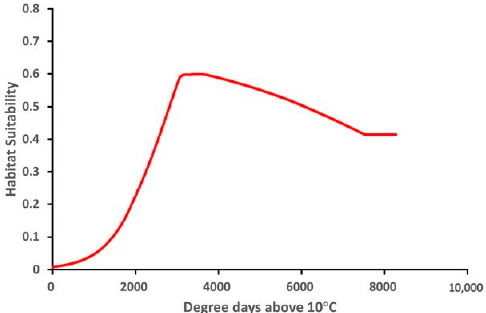
Figure 8. Relationship of habitat suitability for Thaumatotibia leucotreta response to Degree days above 10 °C (Units: Degree days dd).